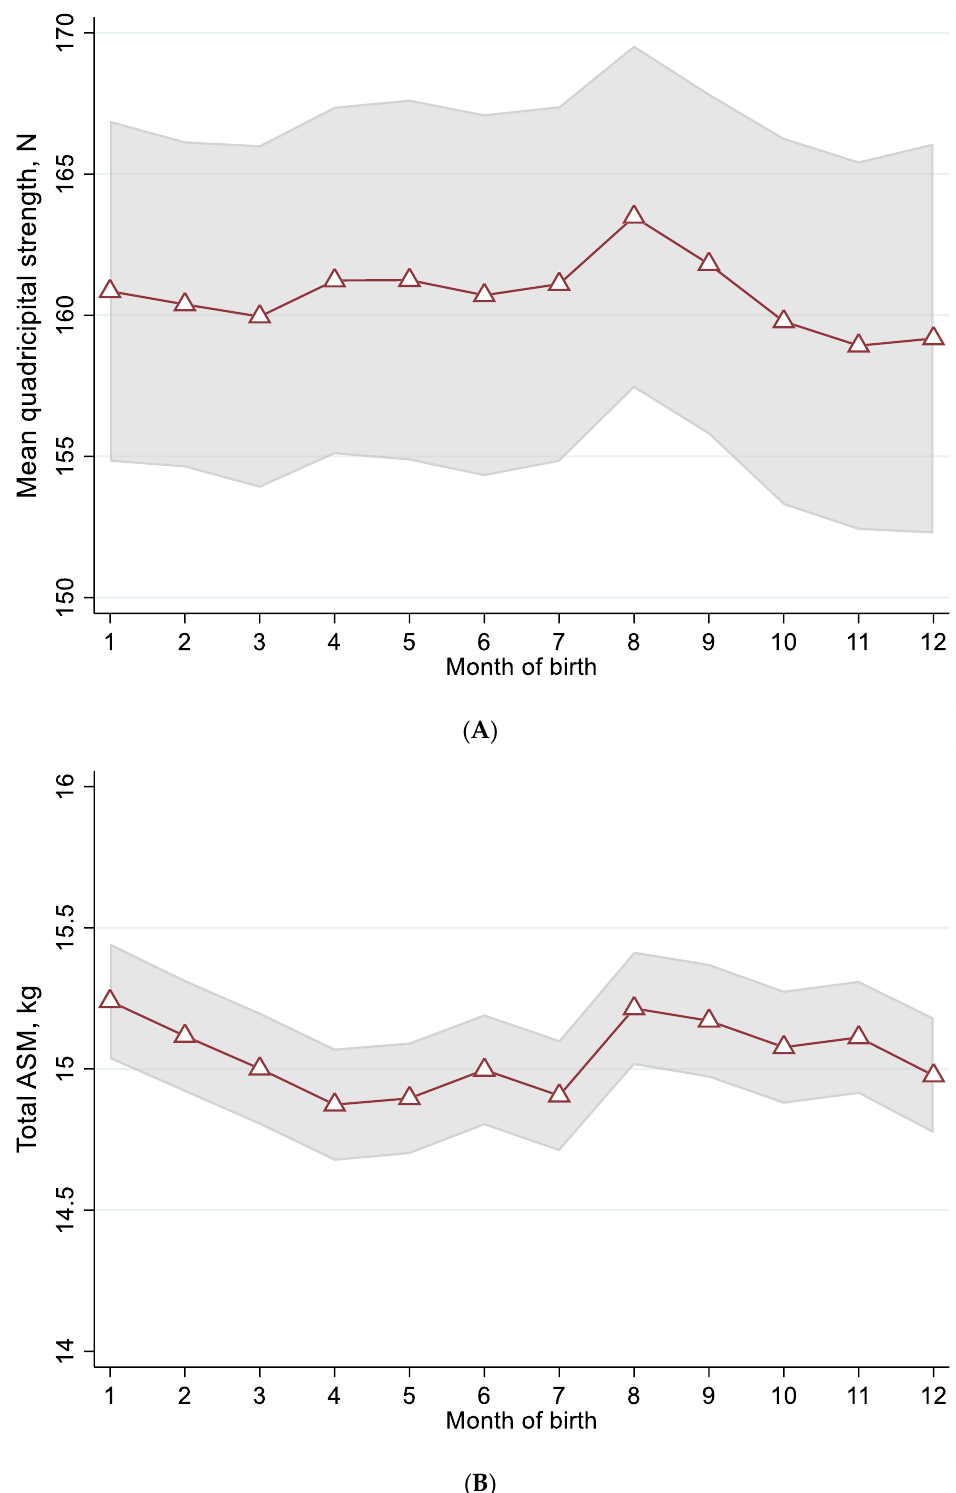
Figure 1. Trigonometric modelling by month of birth of ( A ) mean quadriceps strength ( n = 7178), and ( B ) total appendicular skeletal muscle mass (ASM) ( n = 1321). ( A , B ): Open triangles represent the average predicted values for respectively “Mean quadricipital strength” and “Total ASM” according to “Month of birth”. The shaded area represents the average predicted values plus or minus the median of the standard error of the prediction. The two models are adjusted for age, year of birth, latitude of recruitment centre, season of testing, body mass index, number of comorbidities, IADL score, regular physical activity, sun exposure at midday, dietary protein intake, dietary